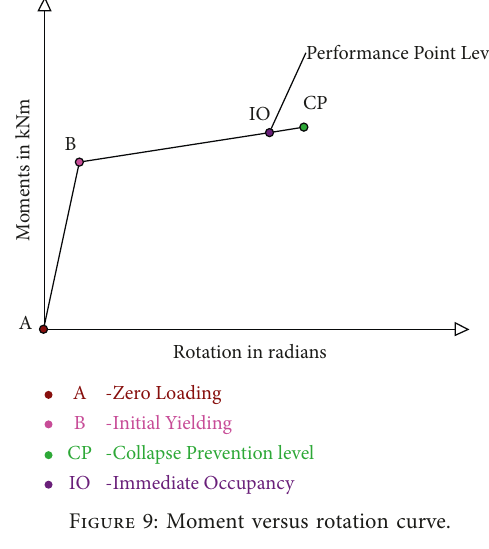
Figure 9: Moment versus rotation curve.